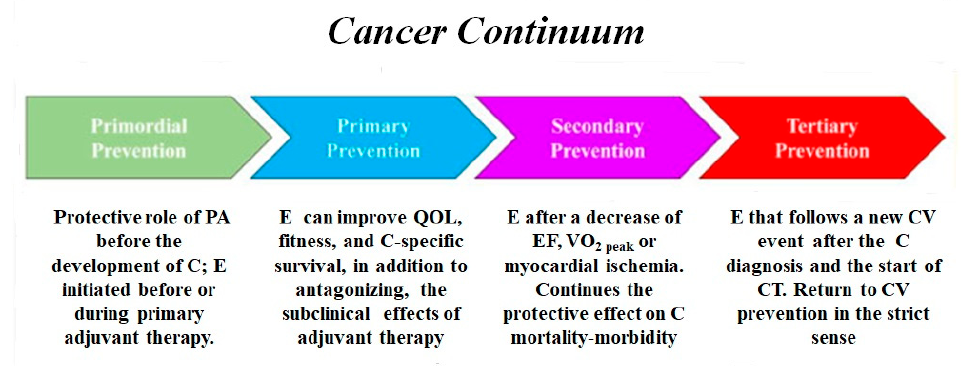
Figure 3. Exercise and cancer continuum, abbreviations as in the text.